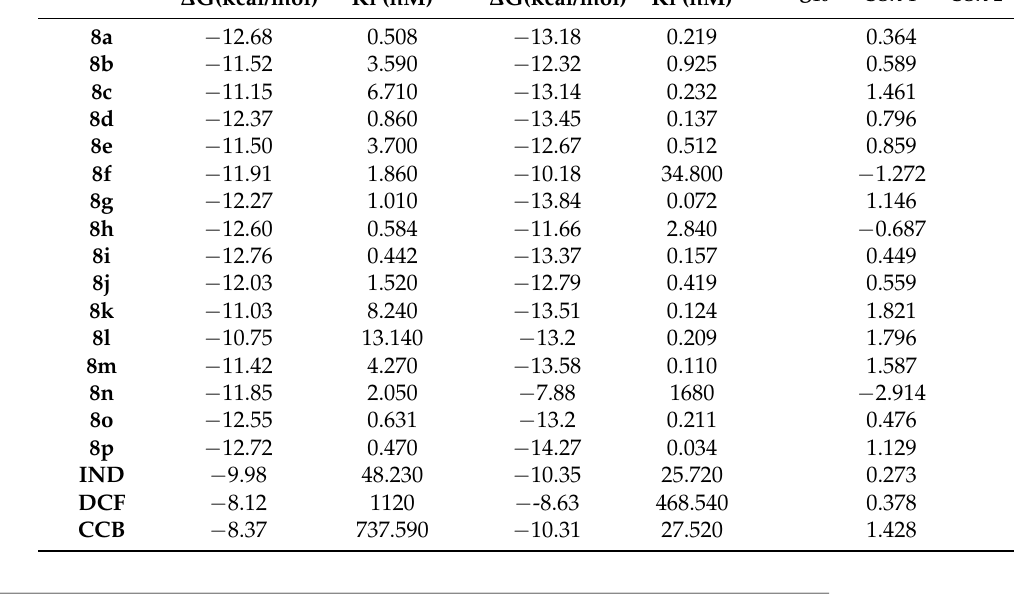
internal hydrophobic side pocket in COX-2 that enlarges the volume of the active site by approximately 25% and gives access to Arg513 replaced in COX-1 by a His. Table 1. Docking score ( ∆ G, kcal/mol) and inhibition effect rate (Ki) during docking simulation of NO-IND-OXDs 8a–p and reference drugs (IND, DCF, CCB) for COX-1 and COX-2.